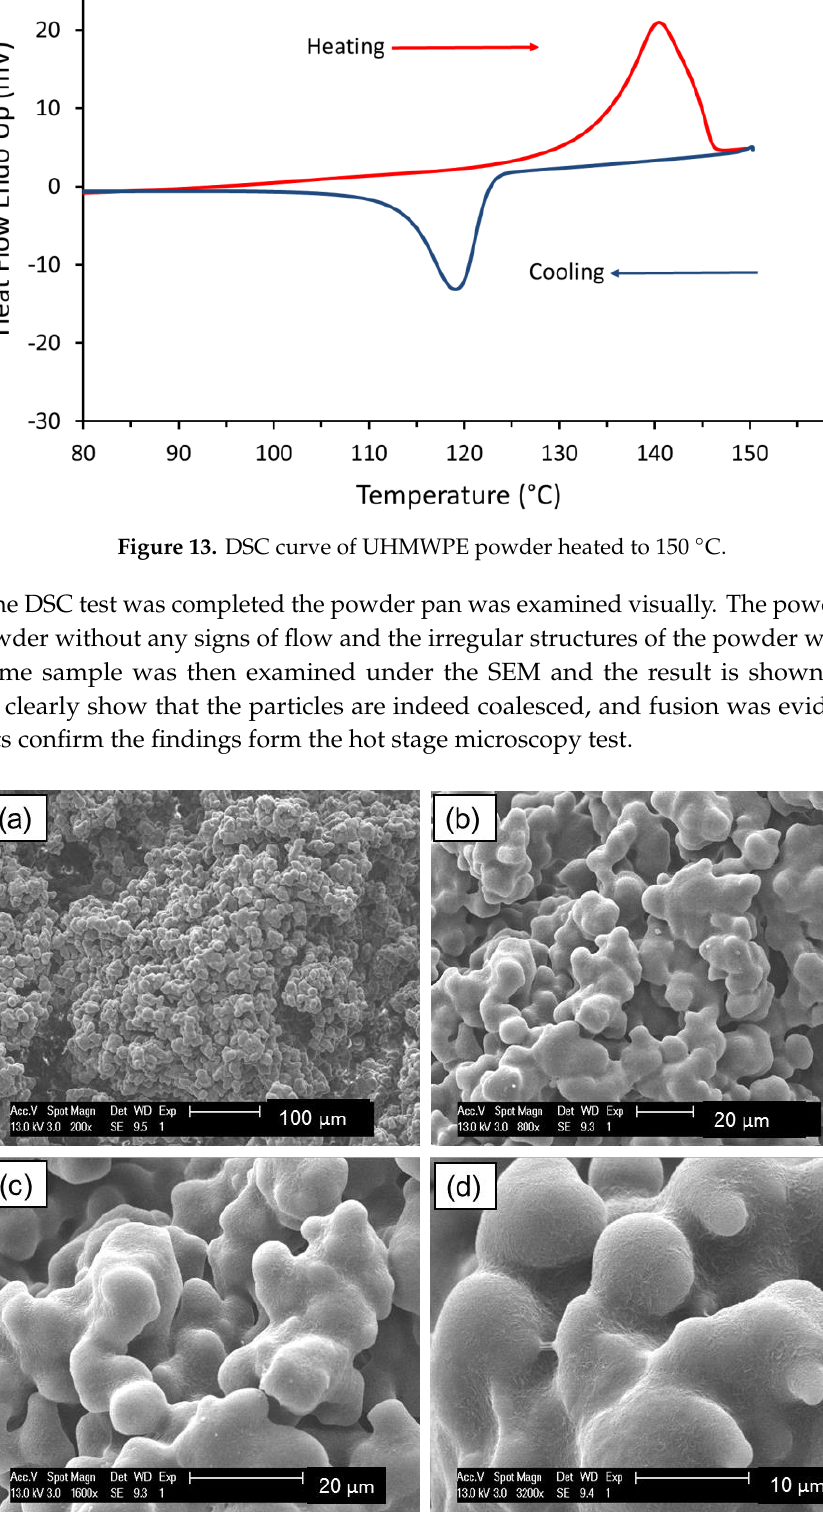
Figure 14. SEM images of UHMWPE powder heated to 150 °C and cooled down to room temperature. Magnifications: ( a ) 200×; ( b ) 800×; ( c ) 1600× and ( d ) 3200×.